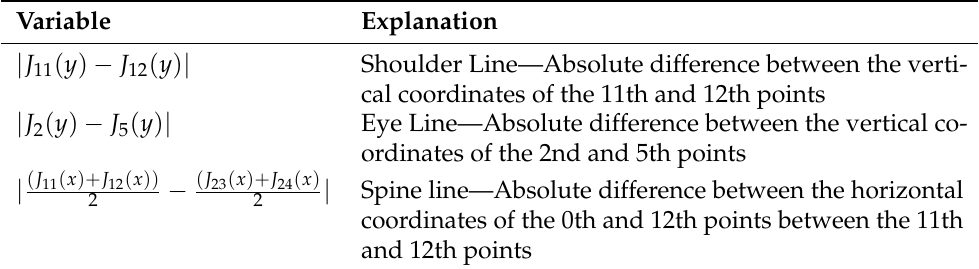
Table 2. Features of the analysed data. Here J i is the position of the i -th joint, x is the horizontal coordinate, and y is the vertical coordinate.